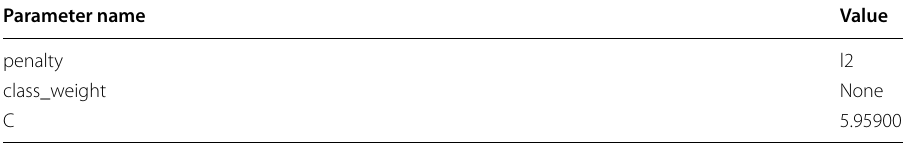
Table 63 Modes of LR tuned hyperparameter values for experiments with the information theft dataset